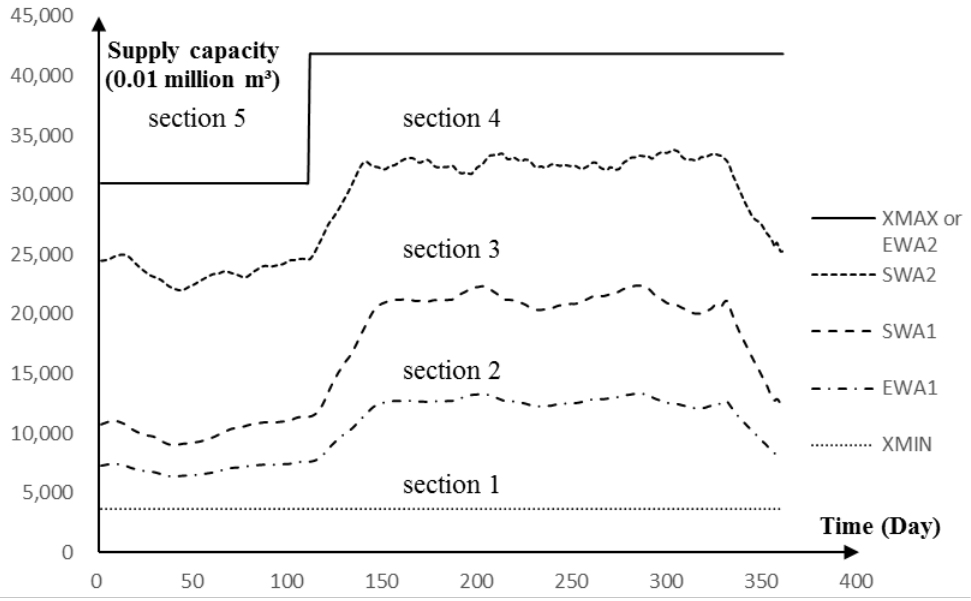
Figure 8. The reservoir operation policy based on JHR.